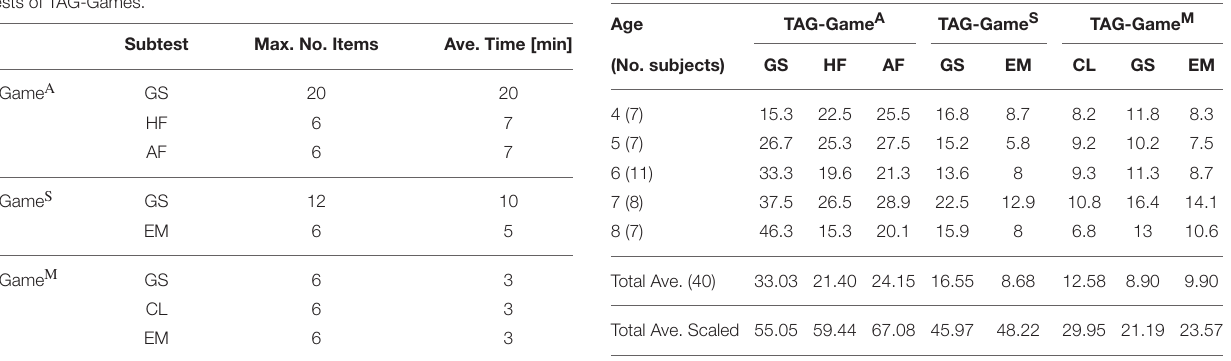
TABLE 3 | Average scores of TAG-Games for each age group.